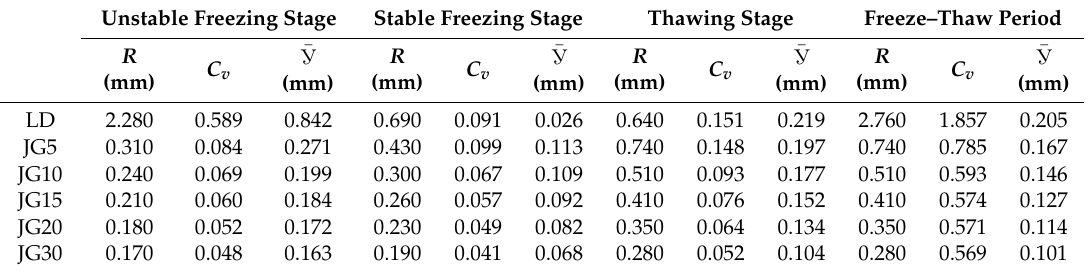
Figure 8. Soil water evaporation rate with different straw mulch thicknesses during the three freeze– thaw stages.